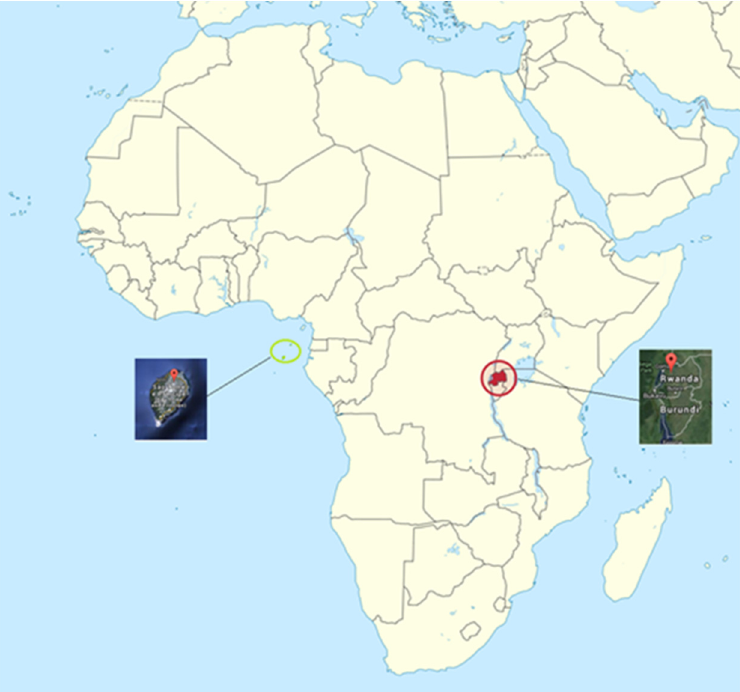
Figure 1. Location of the Vitric Andosol (São Tomé) and the Silandic Andosol (Rwanda) . The extraction by dithionite-citrate estimates the total free iron (Fe d ), including non-crystalline forms of iron (Fe o ) and crystalline oxyhydroxides (goethite, hematite, magnetite) [59,60], while the aluminum extracted by dithionite-citrate (Al d ) includes non-crystalline aluminum forms (excepting non-crystalline aluminosilicates) and aluminum occluded in crystalline iron oxyhydroxides [59]. According to Sanchez et al. [61], São Tomé’s Vitric Andosol has a high Fe d concentration (7.84%), resulting in high P fixation capacity. This soil presents moderate concentrations of non-crystalline Fe and Al, but a large content of crystalline iron oxyhydroxides (Table 1). Conversely, the Rwandan Silandic Andosol has a Fe o /Fe d ratio of 0.75, which indicates the predominance of non-crystalline over crystalline iron forms. The higher Al d compared to Al o in the São Tomé Vitric Andosol indicates the presence of aluminum in the crystalline lattices of iron oxyhydroxides. Table 1. Location, pH, organic carbon, texture, available P, aluminum, and iron extracted by acid oxalate and by dithionite-citrate and pH in NaF of the studied soils.